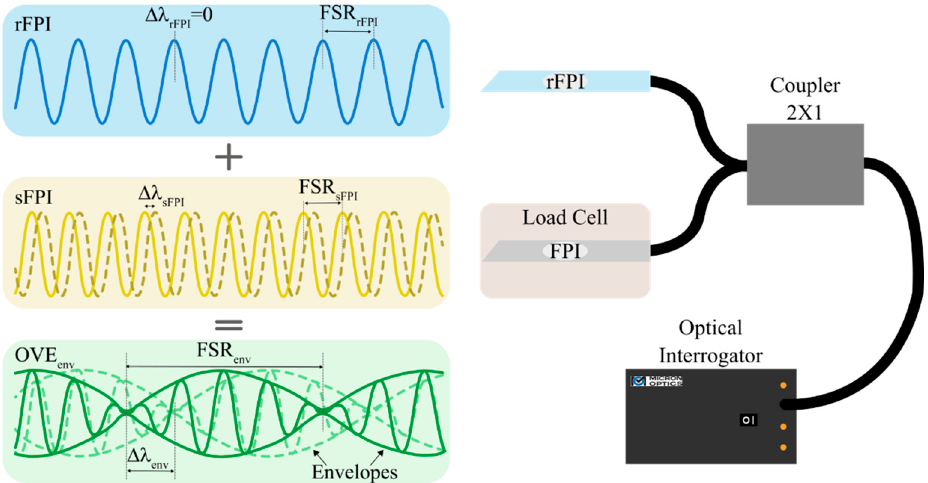
Figure 3. Schematic representation of the OVE-based load cells’ spectral monitoring mechanism in a parallel configuration. The solid and dashed lines represent the spectra before and after applying an external stimulus, respectively.